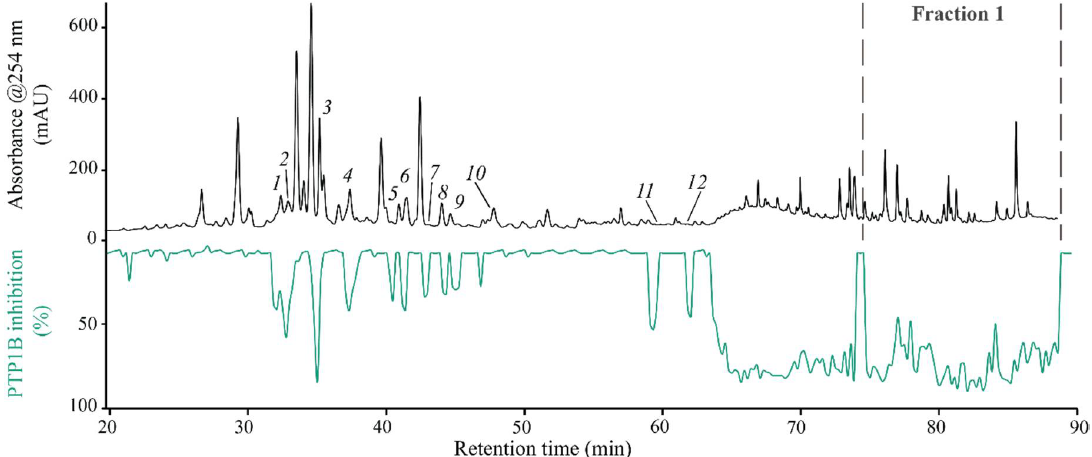
Figure 1. High-resolution PTP1B inhibition profiling of the crude ethyl acetate extract of M. albicans . Black trace: UV absorption at 254 nm; Green trace: PTP1B inhibition profiling.